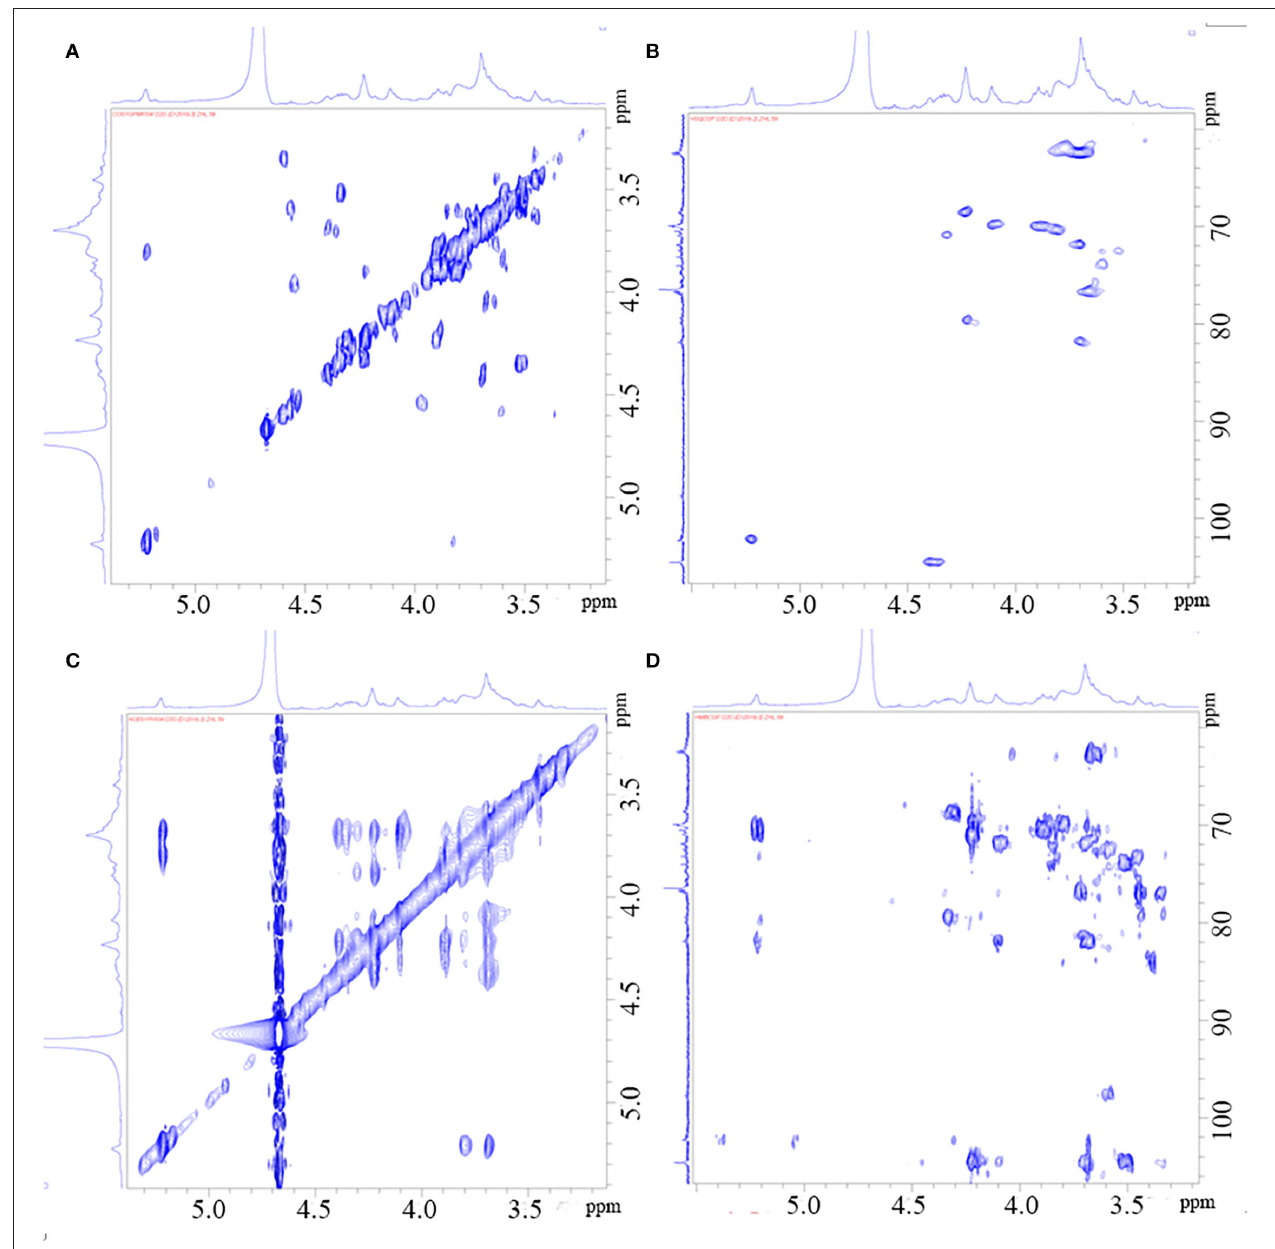
FIGURE 3 | HH-Cosy spectrum of PGP (A) ; HSQC spectrum of PGP (B) ; NOESY spectrum of PGP (C) ; HMBC Cosy spectrum of PGP (D)